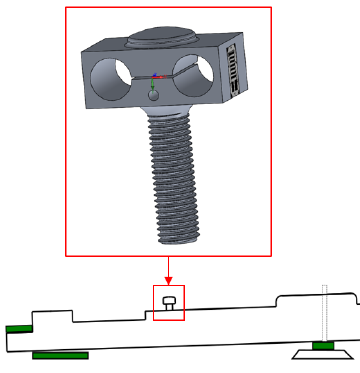
Figure 12. Load cell